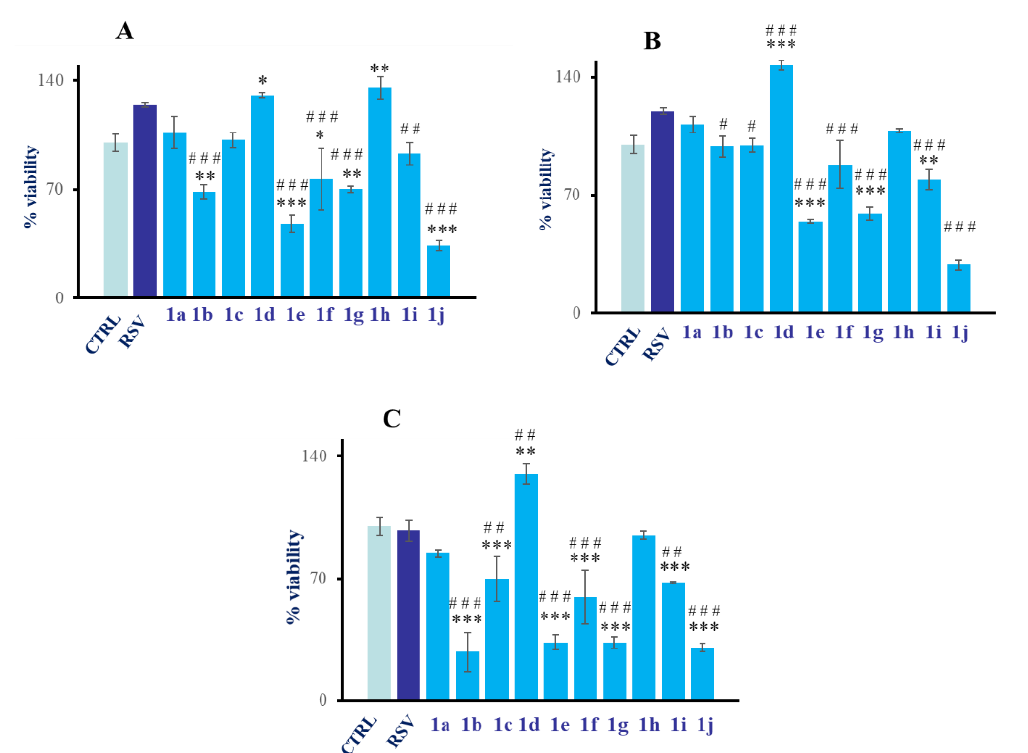
Figure 2. MTT test on HGFs treated with compounds 1a – j and RSV at 10 µM ( A ), 20 µM ( B ), and 50 µM ( C ) for 24 h. * Significance in respect to control; # significance in respect to RSV. *** p < 0.0001; ** p < 0.001; * p < 0.01; ### p < 0.0001; ## p < 0.001; # p < 0.01.